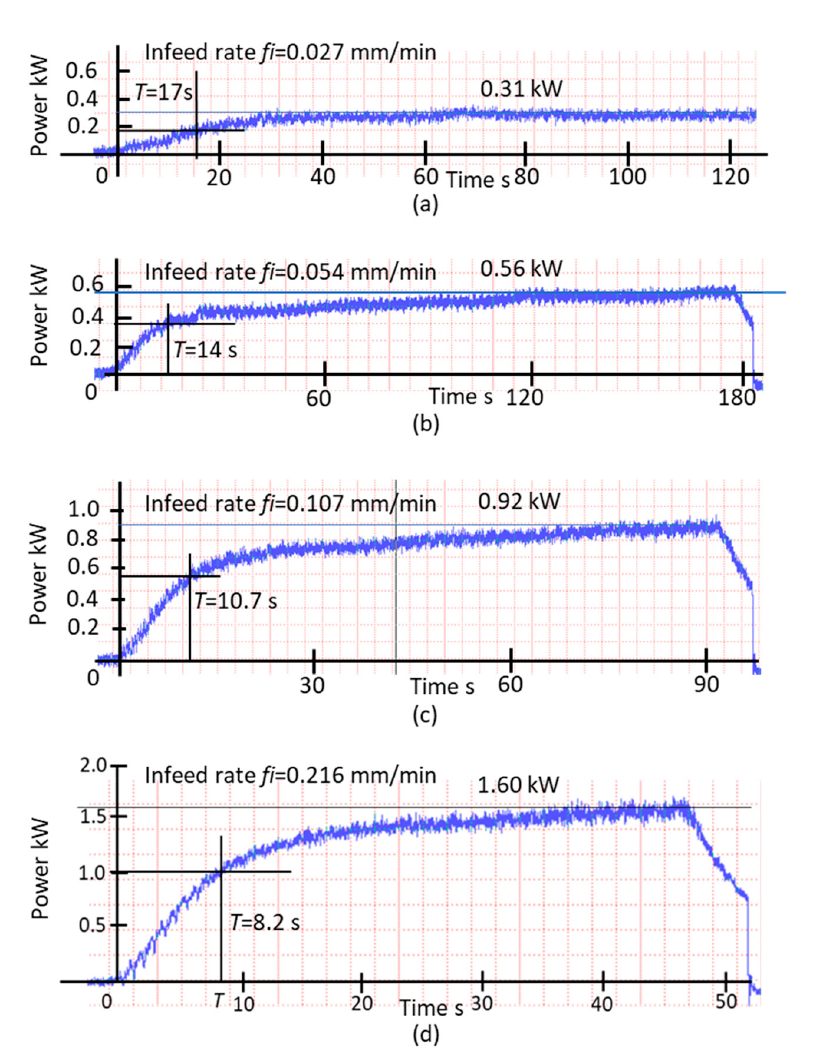
Figure 21. Experimental results of plunge cylindrical grinding and the time constant. ( a ) 𝑄 (cid:3050)(cid:4593) = 0.25 mm³/mm·s; ( b ) 𝑄 (cid:3050)(cid:4593) = 0.5 mm³/mm·s; ( c ) 𝑄 (cid:3050)(cid:4593) = 1.0 mm³/mm·s; ( d ) 𝑄 (cid:3050)(cid:4593) = 2.0 mm³/mm·s.